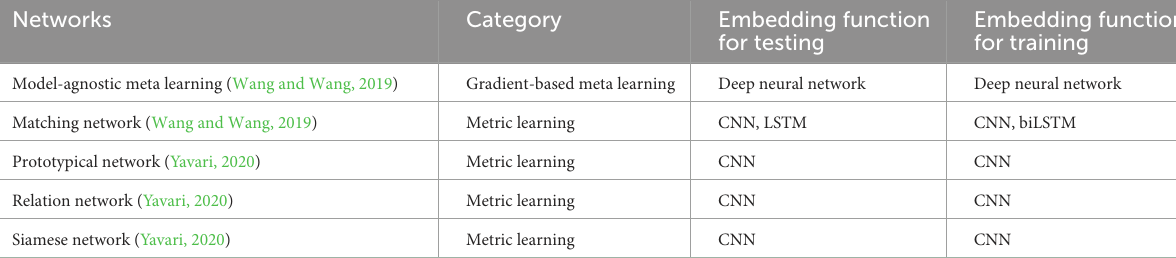
TABLE 1 Types of meta learning algorithms.